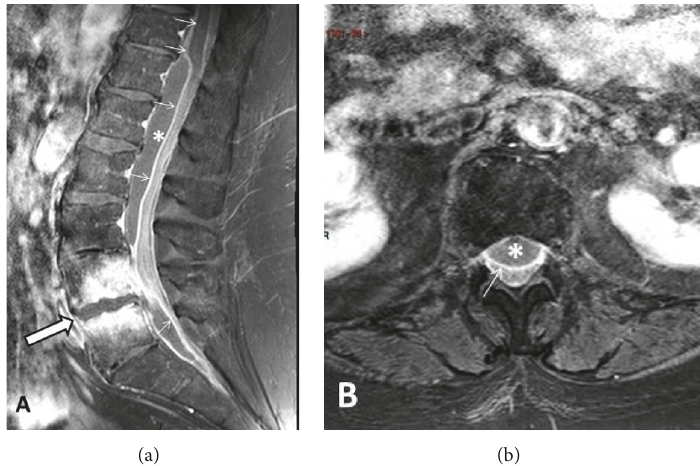
Figure 1: Lumbar spine MR work-up at admission. (a) Midsagittal contrast-enhanced (CE) T1-weighted view with Fat Suppression (FS) option. Spondylodiscitis at L4-L5 level (arrow) with necroticocystic intersomatic abscess and strong enhancement of the adjacent bone marrow. Epidural abscess extending from T11/T12 to S1/S2 was well seen (asterisk) together with intense enhancement of the dura (arrows). (b) Axial–transverse CE T1-weighted view through the L1 level. Anterior epidural abscess is well seen (asterisk) impinging on posteriorly displaced thecal sac. Note intense enhancement of the dura (arrow).